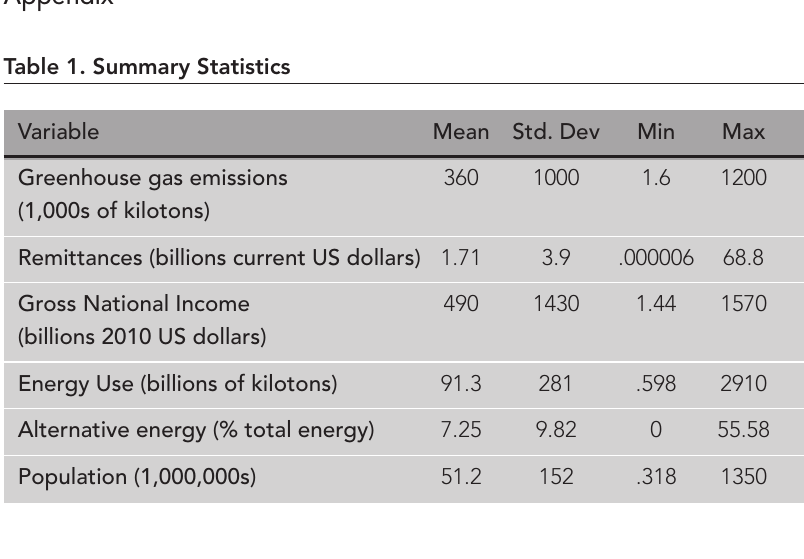
Table 2. Countries in